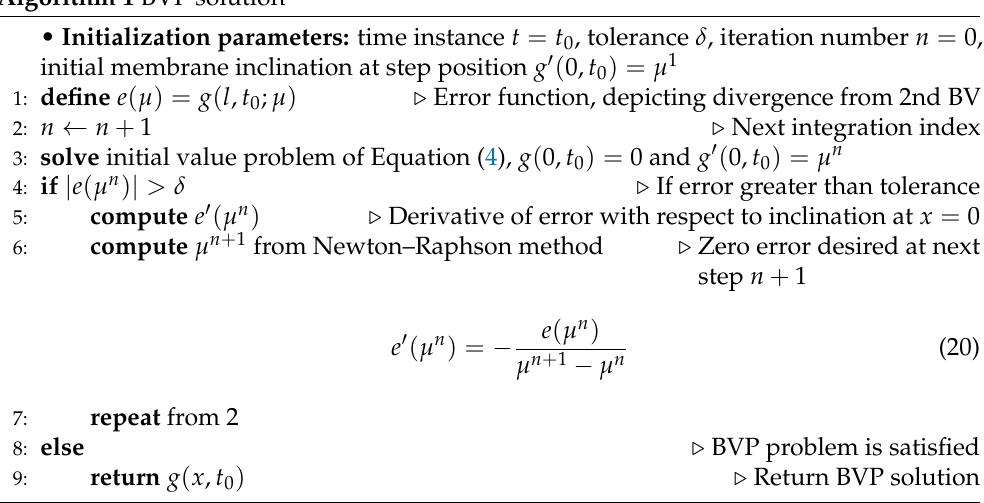
Algorithm 1 BVP solution